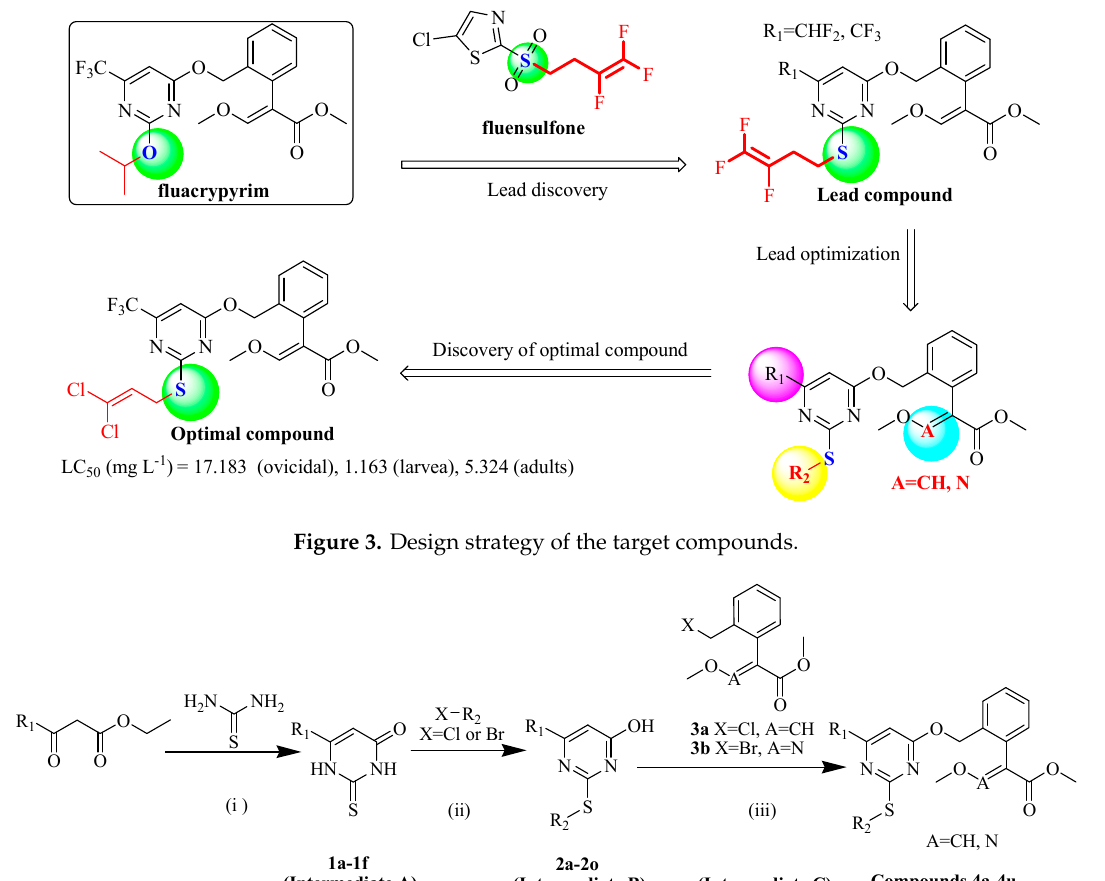
Figure 4. Synthetic procedure for the title compounds. Reagents and conditions: ( i ) EtONa, EtOH, reflux, 4–6 h. ( ii ) K 2 CO 3 , N , N -Dimethylformamide (DMF), 40–50 °C, 3–5 h. ( iii ) K 2 CO 3 , DMF, 60–80 °C, 3–5 h.